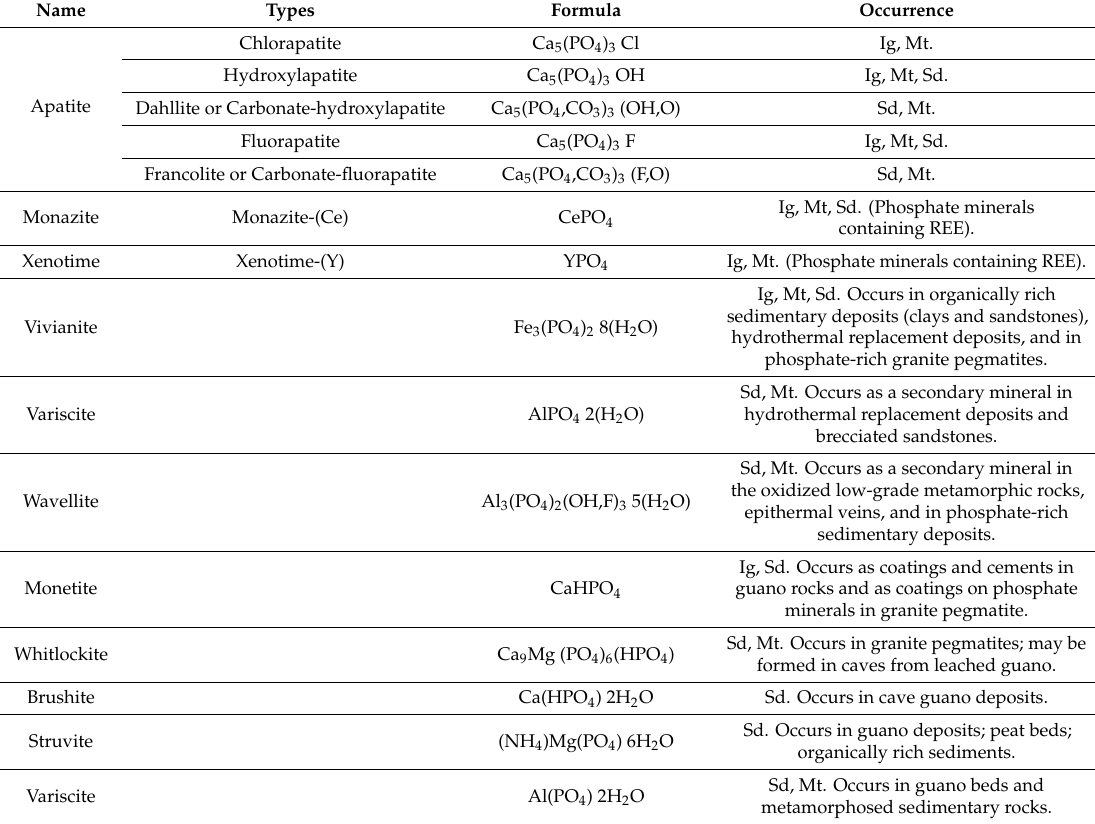
Table 2. Abundant phosphate minerals and their occurrence.